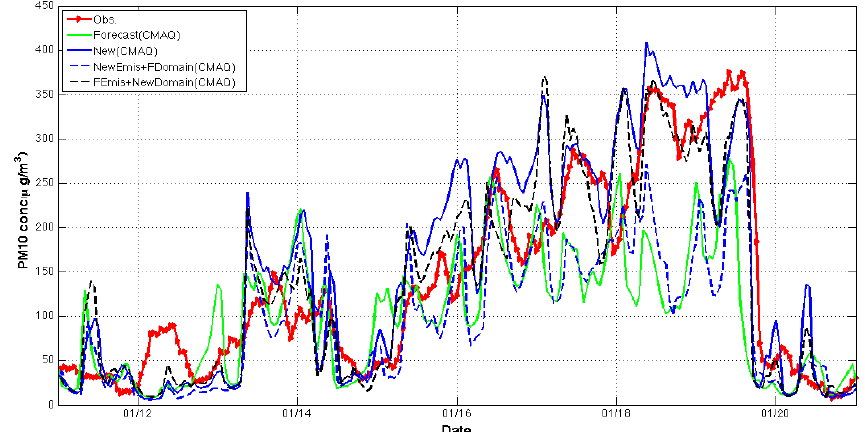
Figure 9. The time series of the PM 10 hourly concentration during the air pollution episode in January 2010. The red solid line represents the observations, being the averaged PM 10 hourly concentration observed in the 10 NSAQ stations in the Beijing MEMC monitoring network. The “New(CMAQ)” shows a much better model performance about the hourly concentration during the air pollution episode than the forecast due to the improvement of model domain and